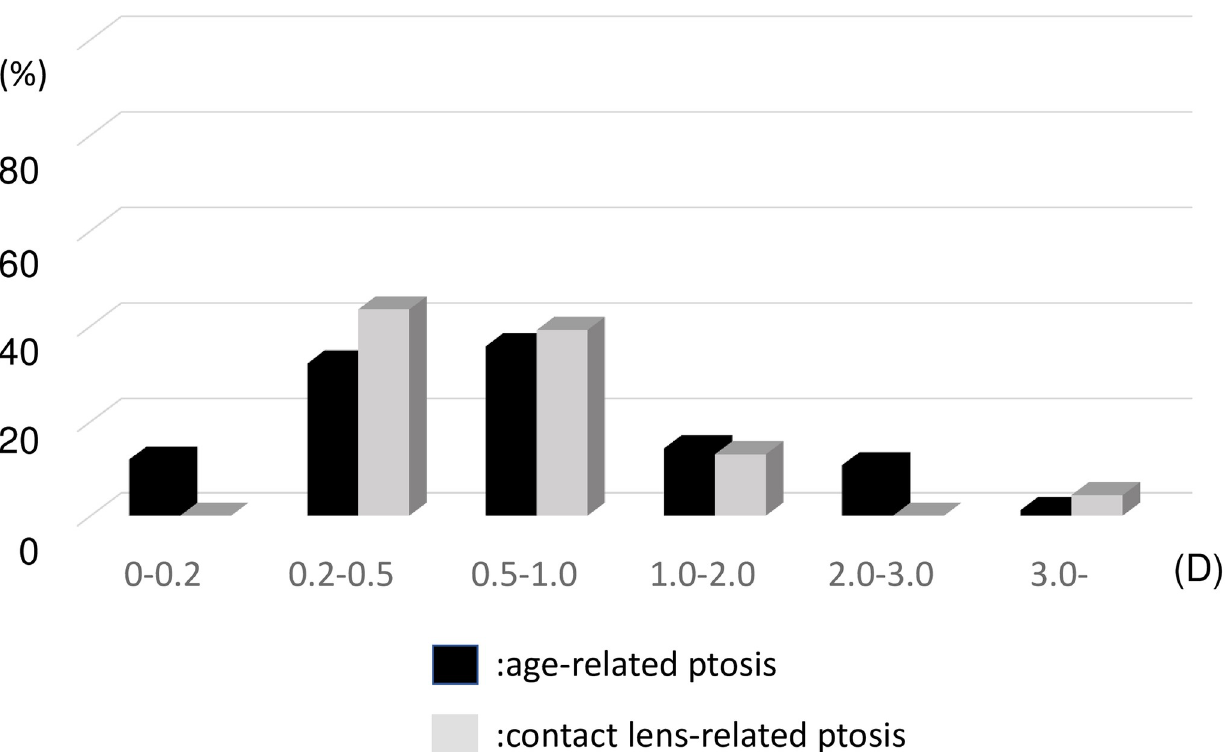
Fig 3. Distribution of blepharoptosis surgery-induced astigmatism measured using the Jaffe method in the age-related ptosis and contact lens- related ptosis groups. D: Diopter.